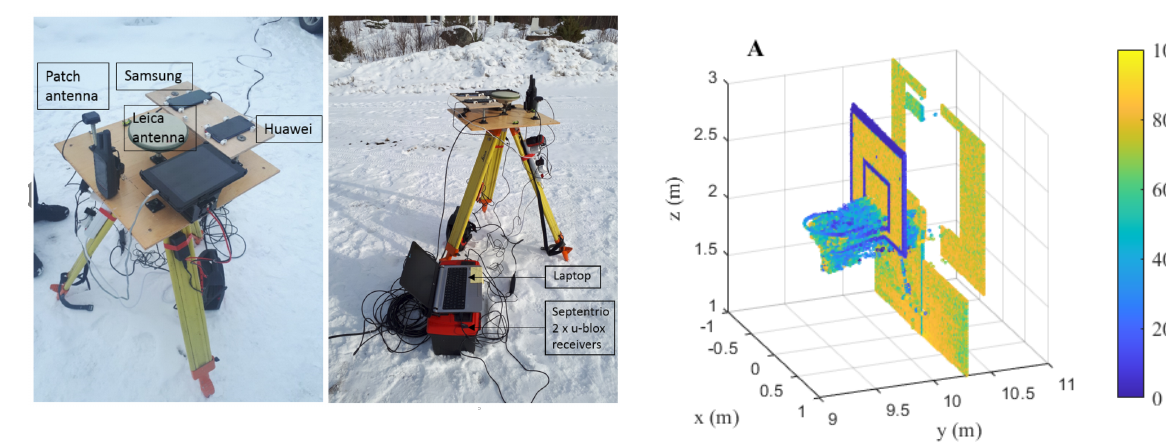
Figure 2: Experimental measurement campaign with four differ- ent GNSS receivers, one with two antenna configurations. Re- produced from [Lehtola et al., 2019b].